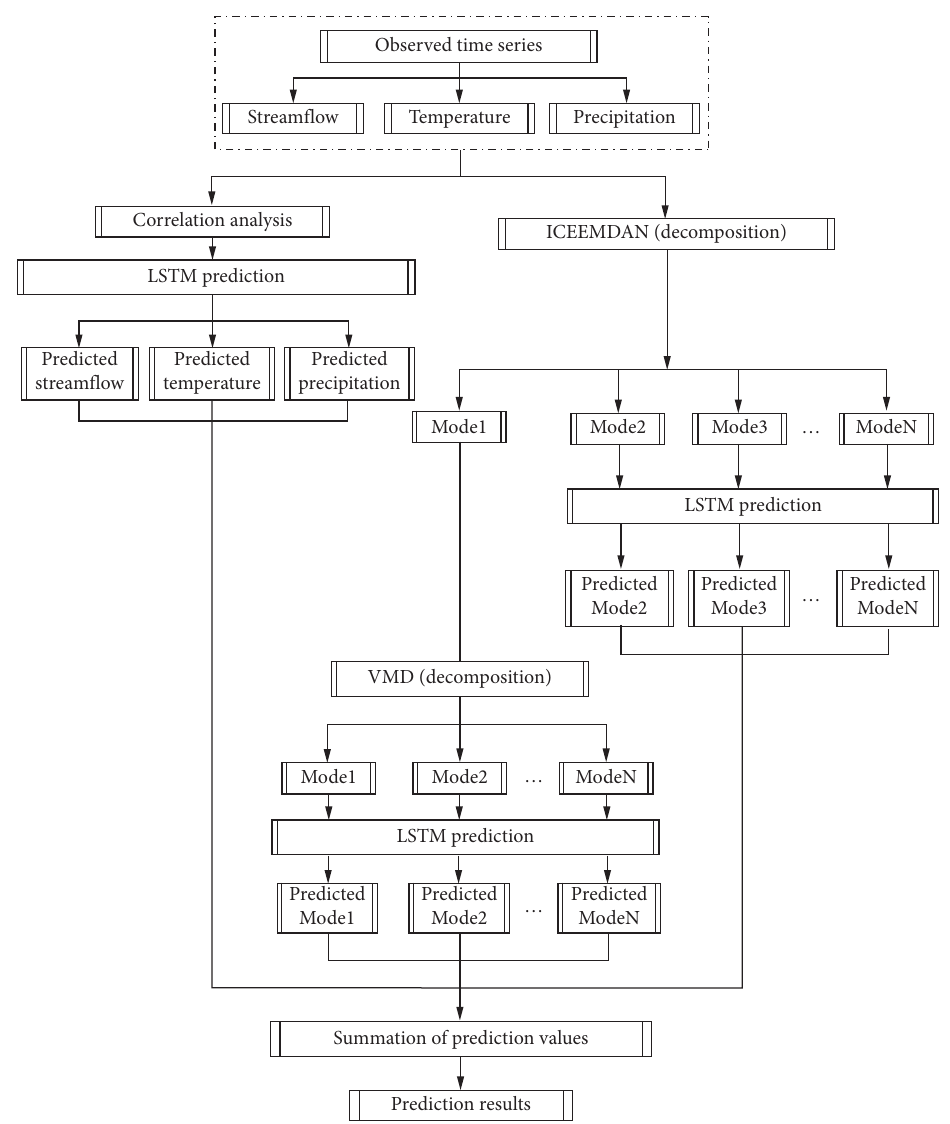
Figure 1: A flowchart explaining the IVL